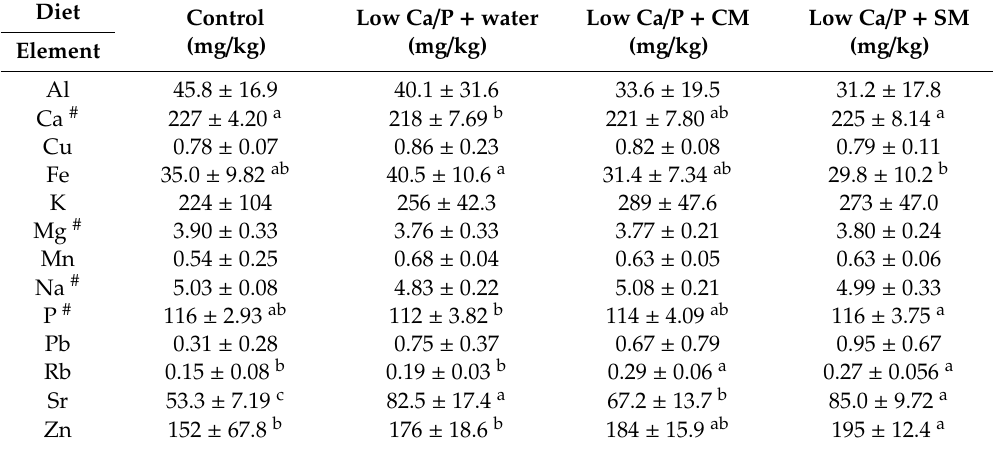
Table 5. Mineral concentrations in the femora of rats fed di ff erent